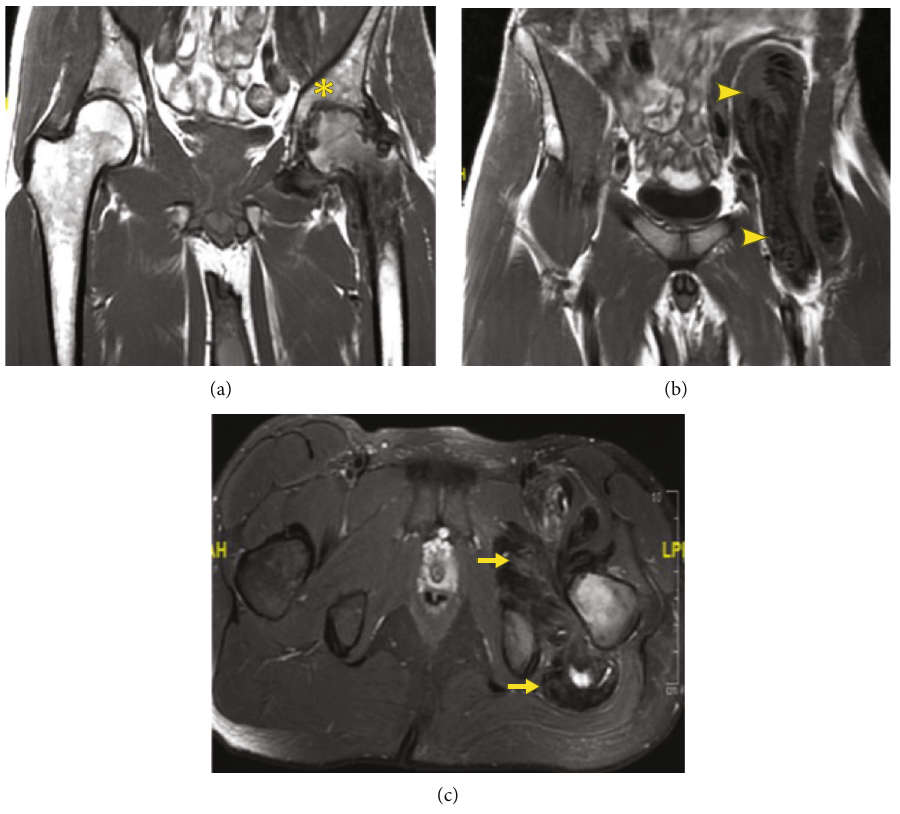
Figure 1: Representative MRI slices from of a 29-year-old male with D-TGCT in the left hip at diagnosis. Coronal (a, b) and axial (c) MR imaging demonstrating severe arthritic changes of the left hip joint with erosions present ( ∗ ), (b) massive TGCT tumor burden running along the anterior hip and into the pelvis adjacent to the iliacus muscle (arrowhead), and (c) tumor burden both posterior to the hip in the ischiofemoral fossa and anterior to the psoas insertion (arrow).